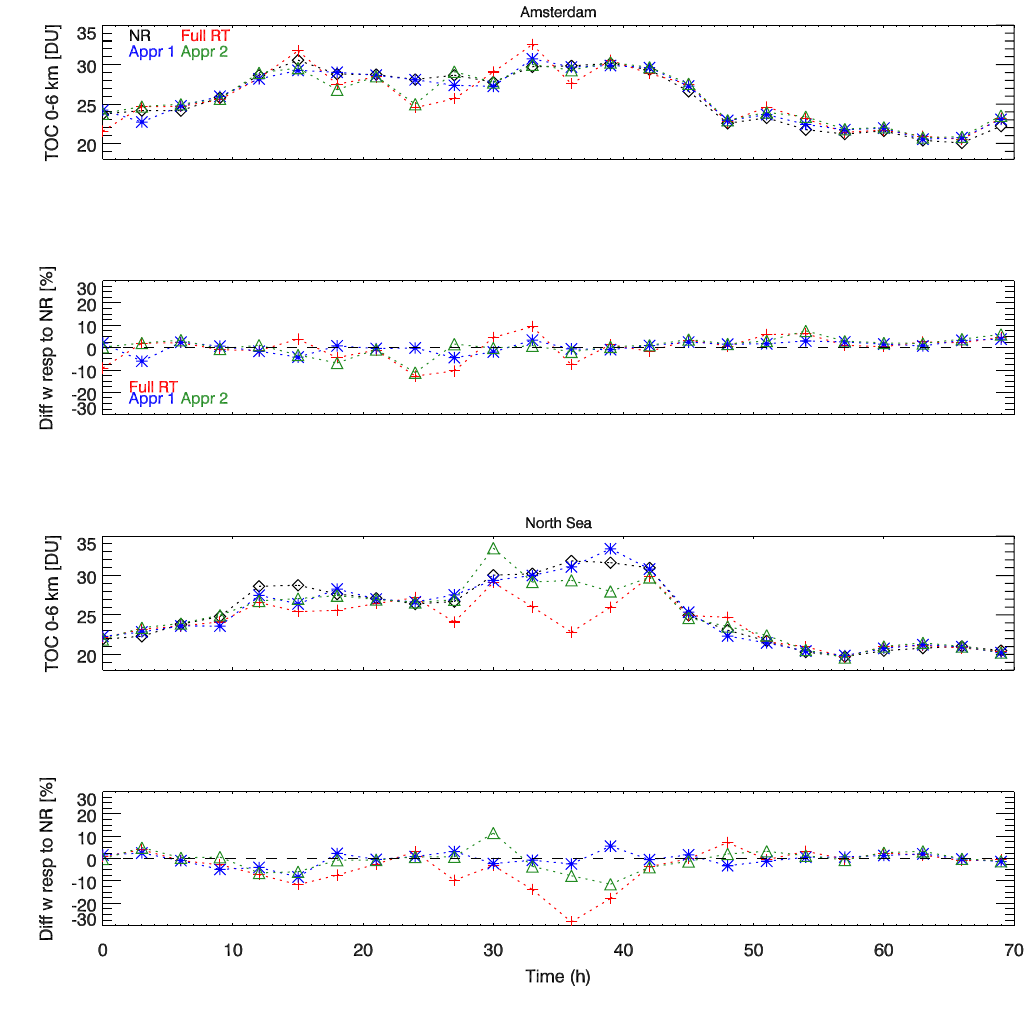
Fig. 10. Time series (19–21 August 2009, 3h sampling) of surface-6km ozone partial column from MOCAGE NR (black), and full RT (red) and approximated MAGEAQ POs (approximation 1: blue, approximation 2: green), over Amsterdam, the Netherlands, and one marine location west of Southern Norway coast (58.1 ◦ N–4.2 ◦ W). Time series of the differences of POs with respect to NR are also